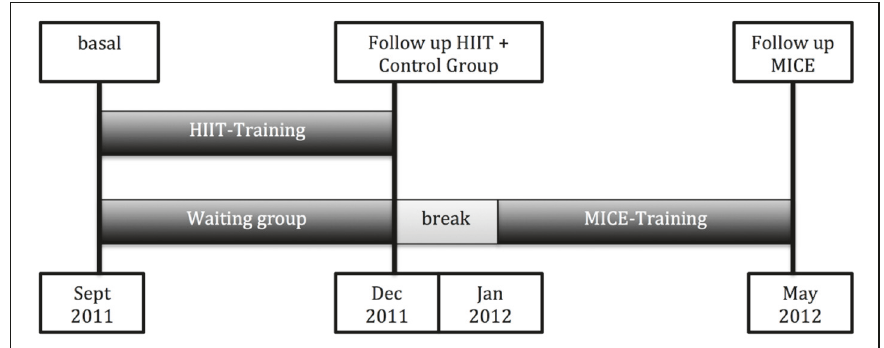
Figure 2: Study design of the RUSH